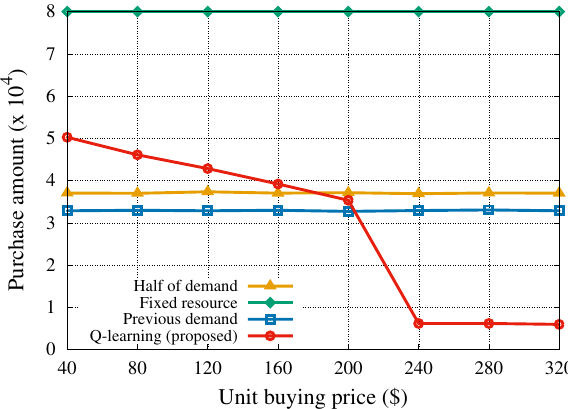
Figure 9. Purchase amount with respect to unit buying